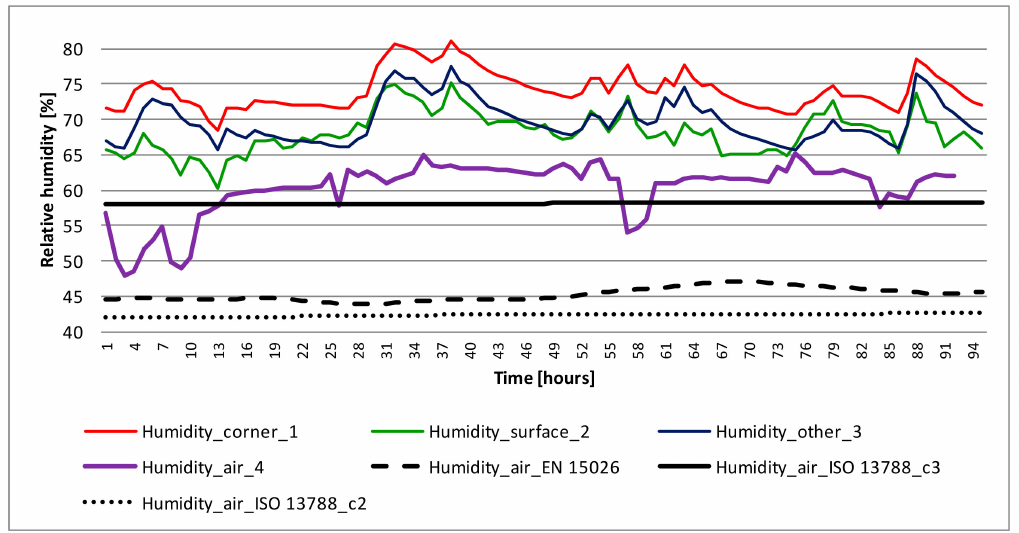
Figure 13. Changes of the relative air humidity for the room with external walls W_2 (symbols as in the picture Figure